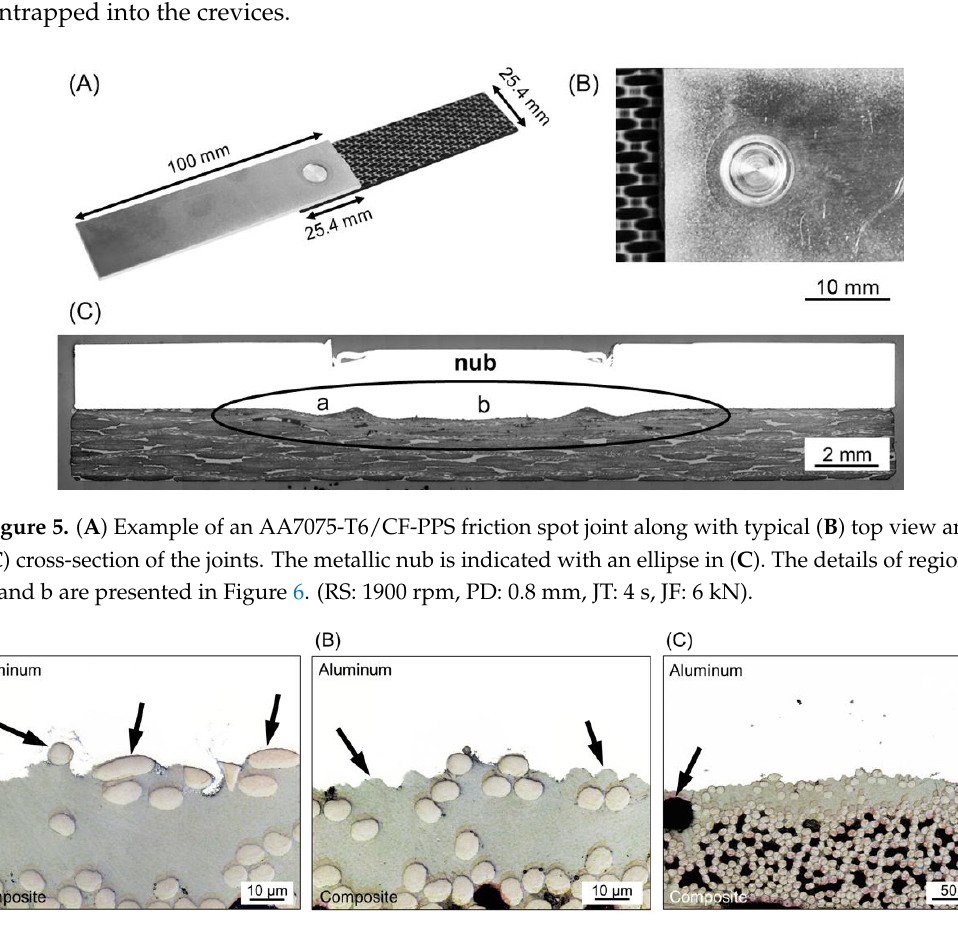
Figure 6. ( A ) Fiber anchoring (region a in Figure 5C), ( B ) PPS matrix entrapment (region b in Figure 5C) by the aluminum surface, and ( C ) volumetric defects in the composite part close to the joint’s interface (region b in Figure 5C).